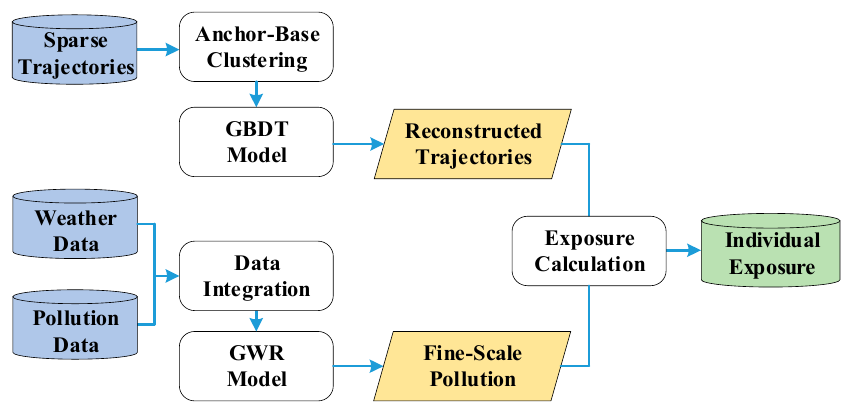
Figure 2. The workflow of the dynamic individual exposure estimation method.